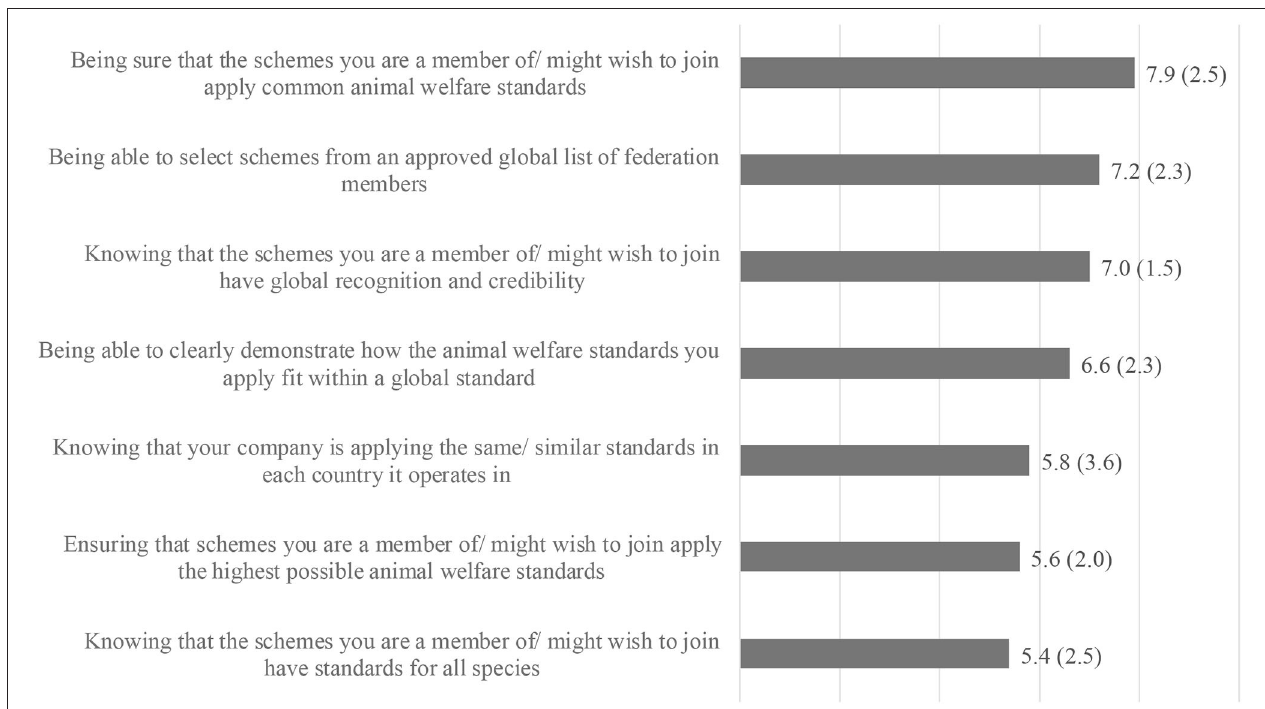
FIGURE 5 | Food businesses’ mean ratings (out of 10) and standard deviation (in parentheses) of the importance of potential benefits of selecting assurance schemes that are a member of the alliance.